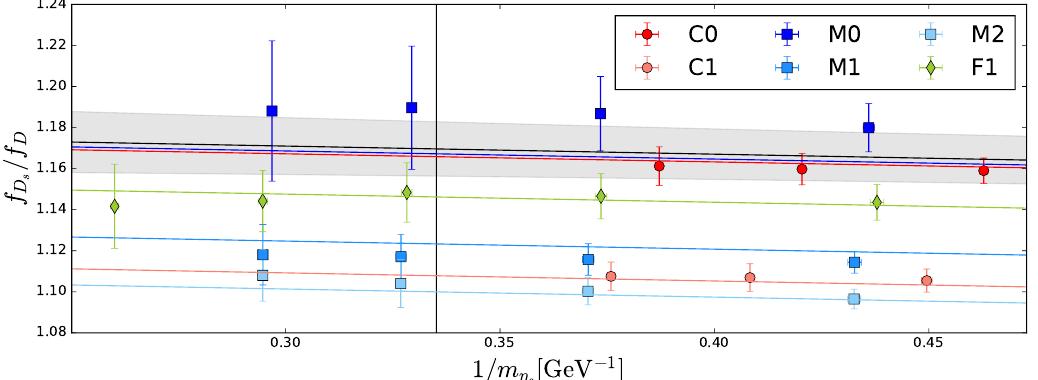
Figure 9 . One example for the global (cid:12)t according to (3.6) for the case of the observable f D In the case presented here the charm-quark mass is (cid:12)xed by the (cid:17) c meson and a pion mass cut of m (cid:25) < 400MeV is employed. The grey band shows the (cid:12)t result at physical pion masses and vanishing lattice spacing. The coloured bands correspond to the (cid:12)t projected to the given pion mass and lattice spacing for the corresponding ensembles. In this (cid:12)t we ignore heavy mass dependent continuum and pion mass terms.